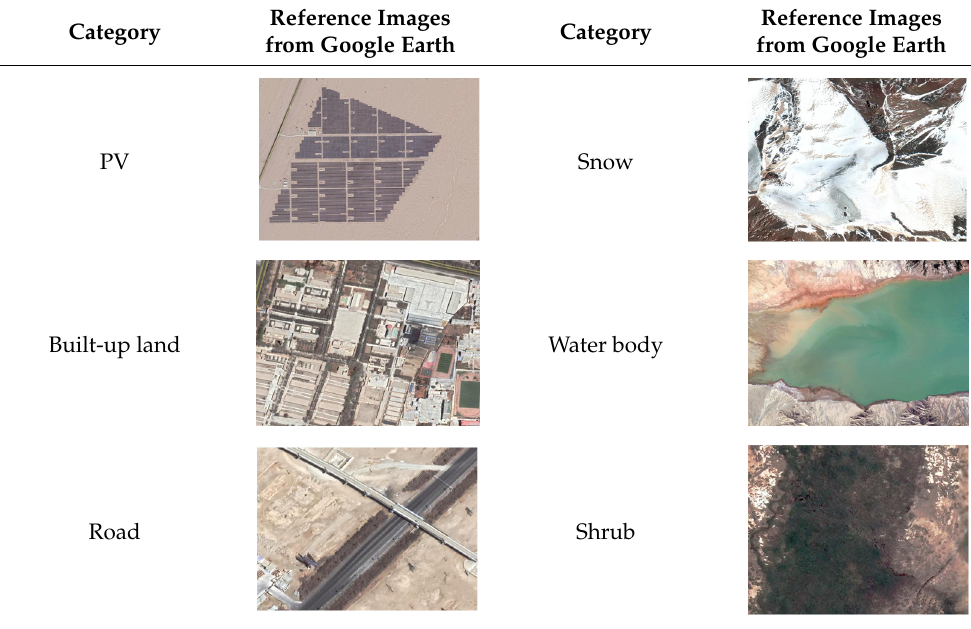
Table 1. Classification categories with examples of high-resolution imagery from Google Earth.